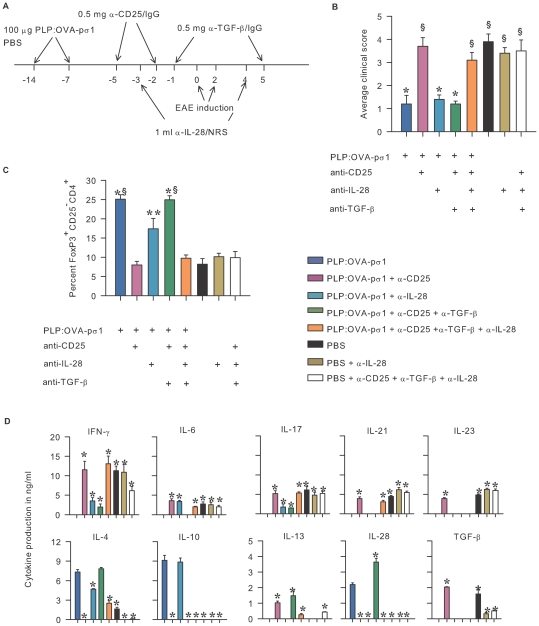
IL-28 is responsible for protection against EAE in Treg cell-depleted PLP:OVA-pσ1-dosed mice.
A. Mice were nasally dosed with 100 µg of PLP:OVA-pσ1 or with PBS on days −14 and −7 relative to EAE induction (day 0). Mice were treated with anti-CD25 mAb on days −5, and −2; anti-TGF-β mAb on days −1 and +5, and/or with anti-IL-28 RS on days −3 and +4, relative to EAE induction. B. In contrast to PLP:OVA-pσ1 (+ NRS)- or PLP:OVA-pσ1 + anti-IL-28 RS-treated mice, mice treated with PLP:OVA-pσ1 + anti-CD25 mAb or PLP:OVA-pσ1 + anti-CD25 mAb + anti-TGF-β mAb + anti-IL-28 RS developed pronounced EAE. C. Pooled lymphocytes from MLNs and HNLNs at the peak of EAE were stained for FACS and analyzed for expression of FoxP3. In contrast to PLP:OVA-pσ1-protected mice that received NRS, anti-IL-28 RS, or combination of anti-CD25 and anti-TGF-β mAbs, mice that received PLP:OVA-pσ1 + anti-CD25 mAb + anti-TGF-β mAb + anti-IL-28 RS or PLP:OVA-pσ1 + anti-CD25 mAb showed significantly reduced percentages of FoxP3+ Th2 cells. B and C. * P<0.001, ** P<0.05 vs. PLP:OVA-pσ1 + anti-CD25, § P<0.05 vs. PLP:OVA-pσ1 + anti-IL-28. D. Pooled HNLN and MLN CD4+ T cells were evaluated for production of proinflammatory and anti-inflammatory cytokines by ELISA. CD4+ T cells from mice treated with PLP:OVA-pσ1 + anti-IL-28 RS produced similar amounts of anti-inflammatory cytokines and slightly elevated amounts of proinflammatory cytokines when compared to PLP:OVA-pσ1 (+ NRS)-dosed mice. In contrast to PLP:OVA-pσ1-dosed mice, CD4+ T cells from mice dosed with PLP:OVA-pσ1 + anti-CD25 + anti-TGF-β mAbs + anti-IL-28 RS displayed cytokine profile that closely resembled PLP:OVA-pσ1 + anti-CD25-treated mice. Mean and SD of 5 mice per group are depicted; * P<0.05 vs. PLP:OVA-pσ1-dosed mice.